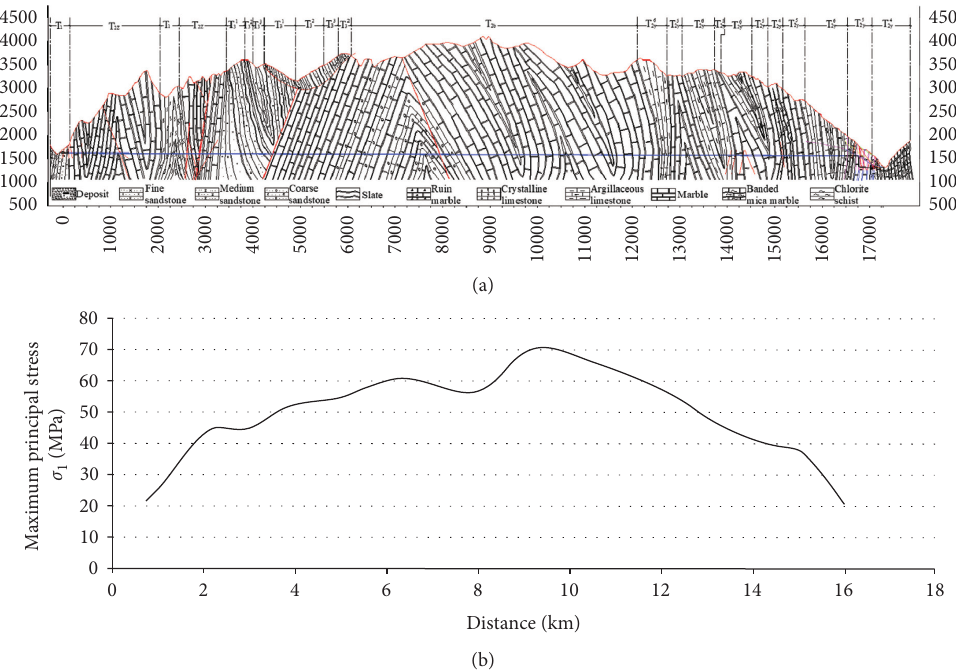
Figure 2: Geological conditions of the Jinping II diversion tunnels: (a) typical geological section (along the axis of 1 # diversion tunnel) and (b) maximum principal stress along the axis of traffic tunnel